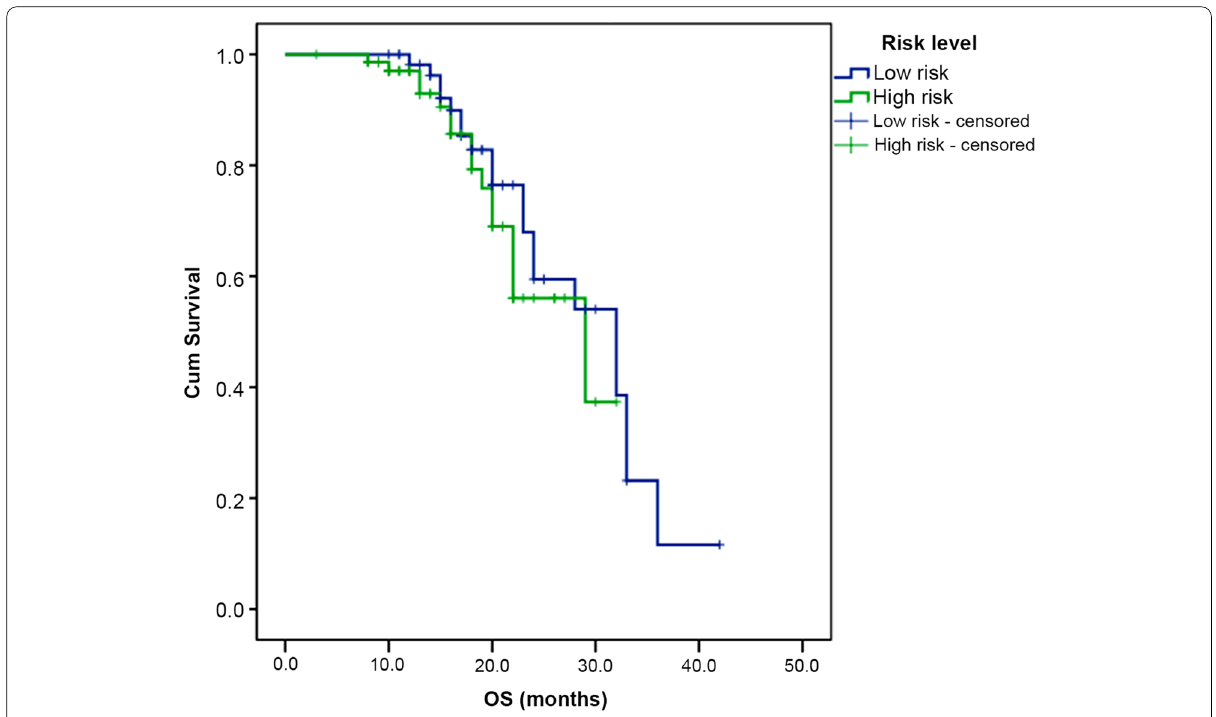
Fig. 1 Kaplan–Meier curve comparing overall survival in low- and high-risk patients